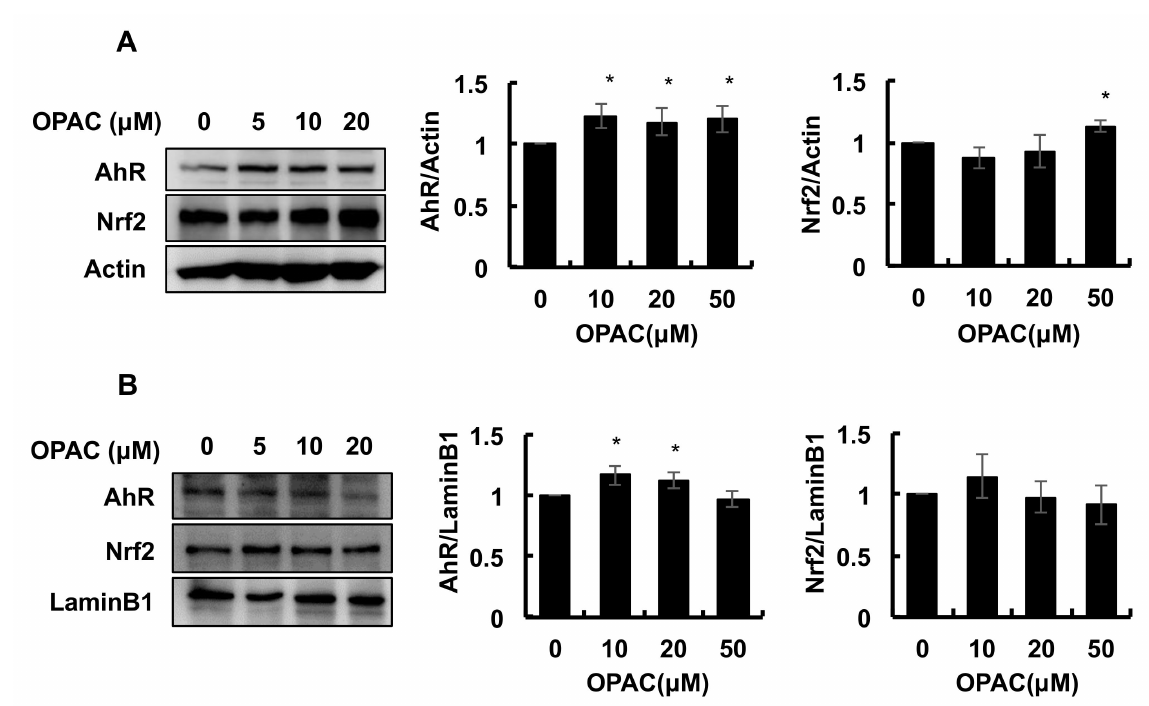
Figure 3. Modulating effects of OPAC on the total and nuclear levels of AhR and Nrf2 proteins. Hepa1c1c7 cells were treated with OPAC for 1 h, and the nuclear fractions, as well as the total cell lysates, were subjected to a Western blot analysis. ( A ) Effect of OPAC on the protein level of AhR and Nrf2 in the whole lysate. ( B ) Effect of OPAC on the nuclear accumulation of AhR and Nrf2. All values are expressed as means ± SD of three separate experiments. * p < 0.05 vs. control.